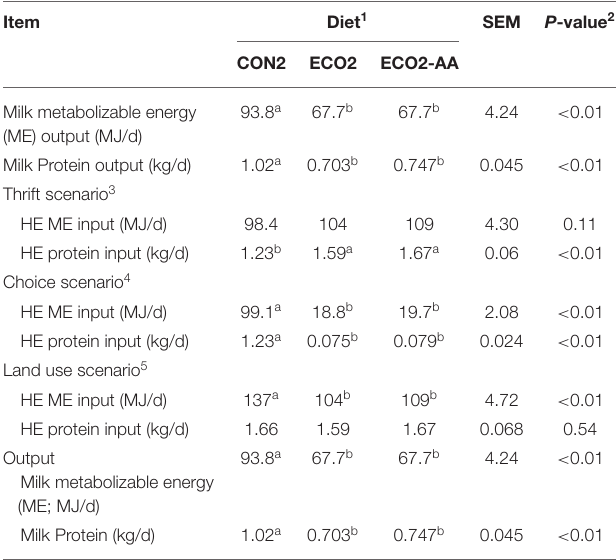
TABLE 10 | Human-edible (HE) nutrients inputs and outputs of late-lactation cows fed a conventional lactation diet or by-product-based diets (Experiment 2). Item Diet 1 SEM P -value